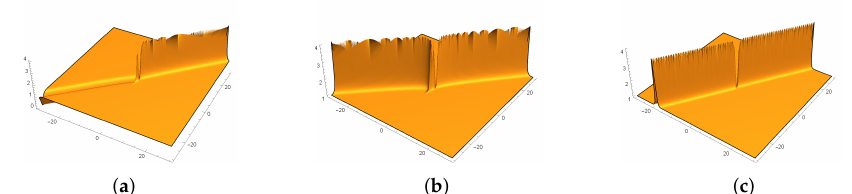
Figure 4. Degenerate two-solution interaction via the solution (19a): ( a ) dark and antidark soliton with a phase shift between two soliton segments as z → ± ∞ , where ρ = 1, λ 1 = 0.5 i , c ( z ) = z and γ 1 = − 1; ( b ) antidark soliton with a phase shift between two soliton segments as z → ± ∞ , where ρ = 1, λ 1 = 0.5 i , c ( z ) = z 2 and γ 1 = − 1; ( c ) antidark soliton with a phase shift between two soliton segments as z → ± ∞ , where ρ = 1, λ 1 = 0.5 i , c ( z ) = e z and γ 1 = − 1.